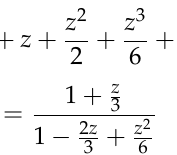
Figure 8. Diagram of characteristic points for RAECM with variable space discretization.